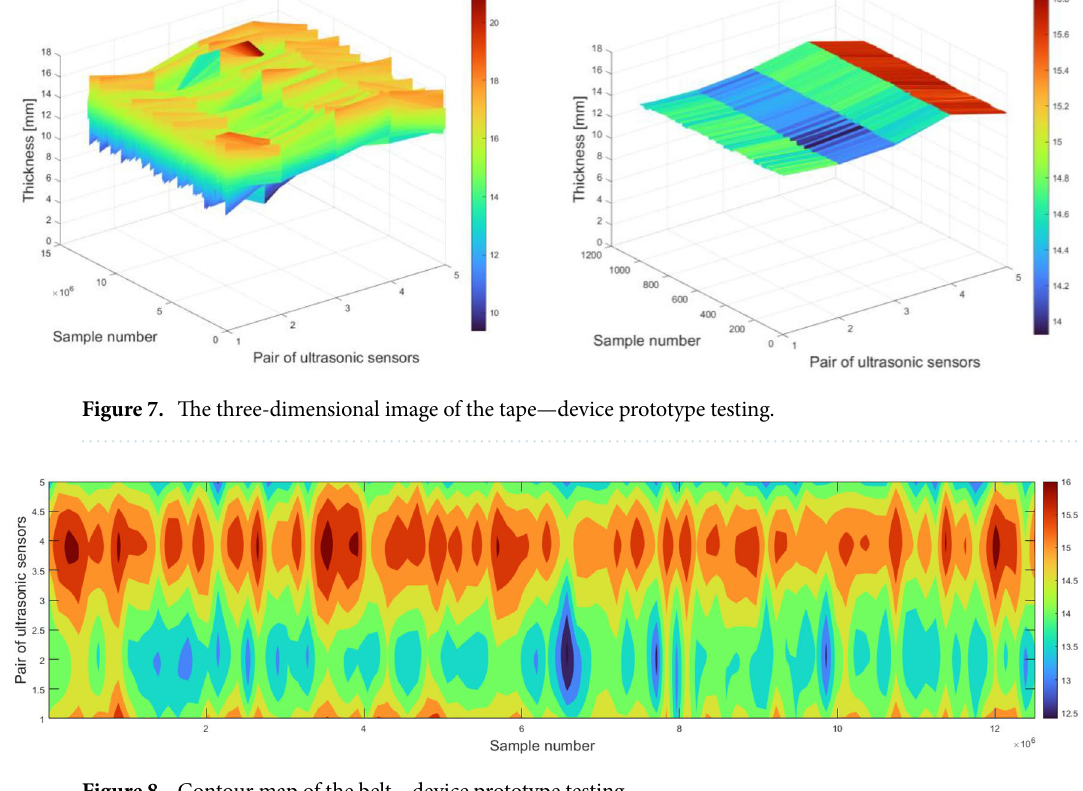
Figure 8. Contour map of the belt—device prototype